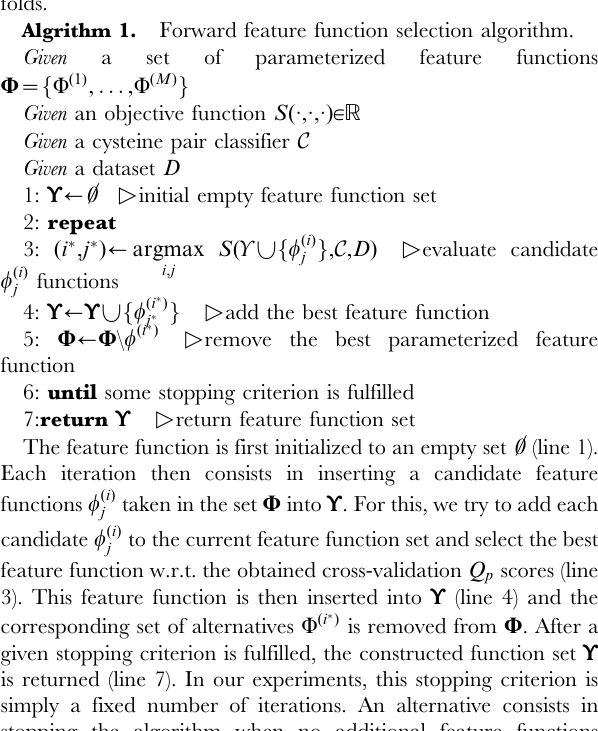
Algrithm 1. Forward feature function selection